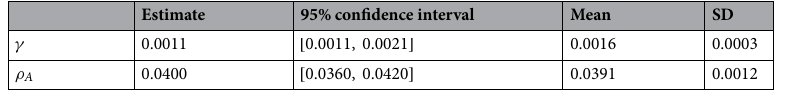
Table 1. Estimates, and the residual bootstrap Confidence intervals, mean and standard deviations for the time-invariant parameters for Utah. The latter three are computed based on 1000 bootstrap resamples.